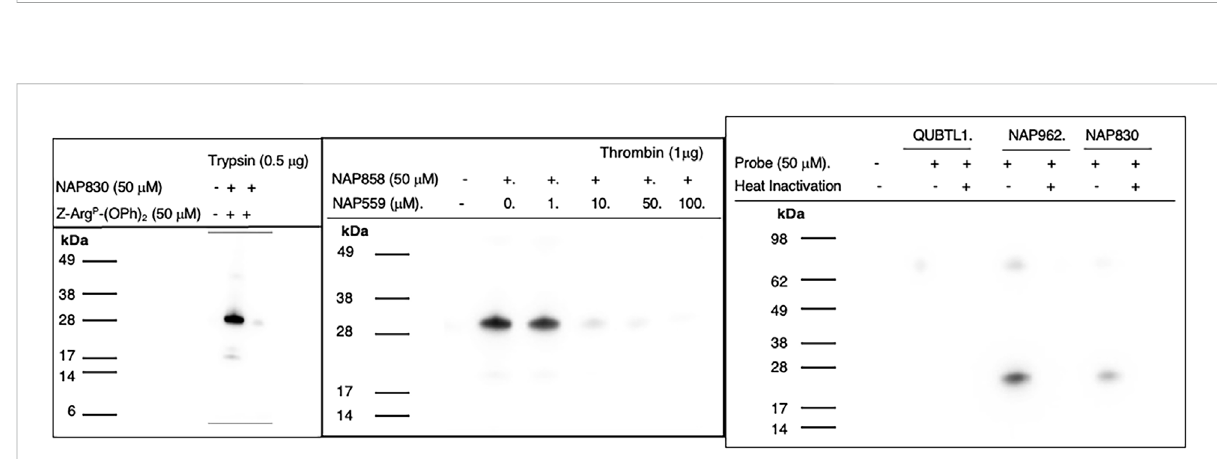
FIGURE 8 Activity Based Pro fi ling of Trypsin-like serine proteases. (A) trypsin was treated (±) with NAP830, for 30 min, at 37 ° C (± pretreatment with Z- Arg P